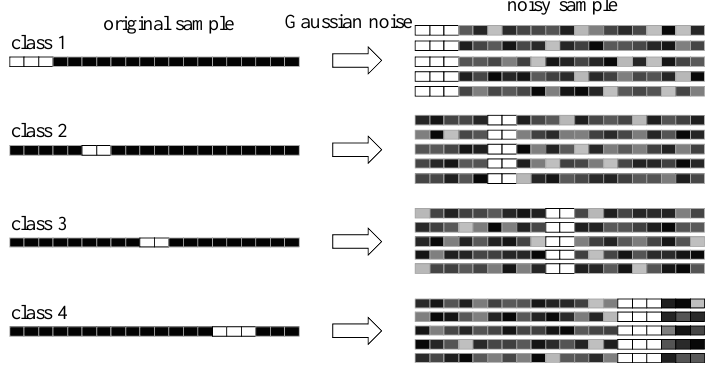
Table 2. Number of input variables corresponding to white and black pixels remained for various values of n . s